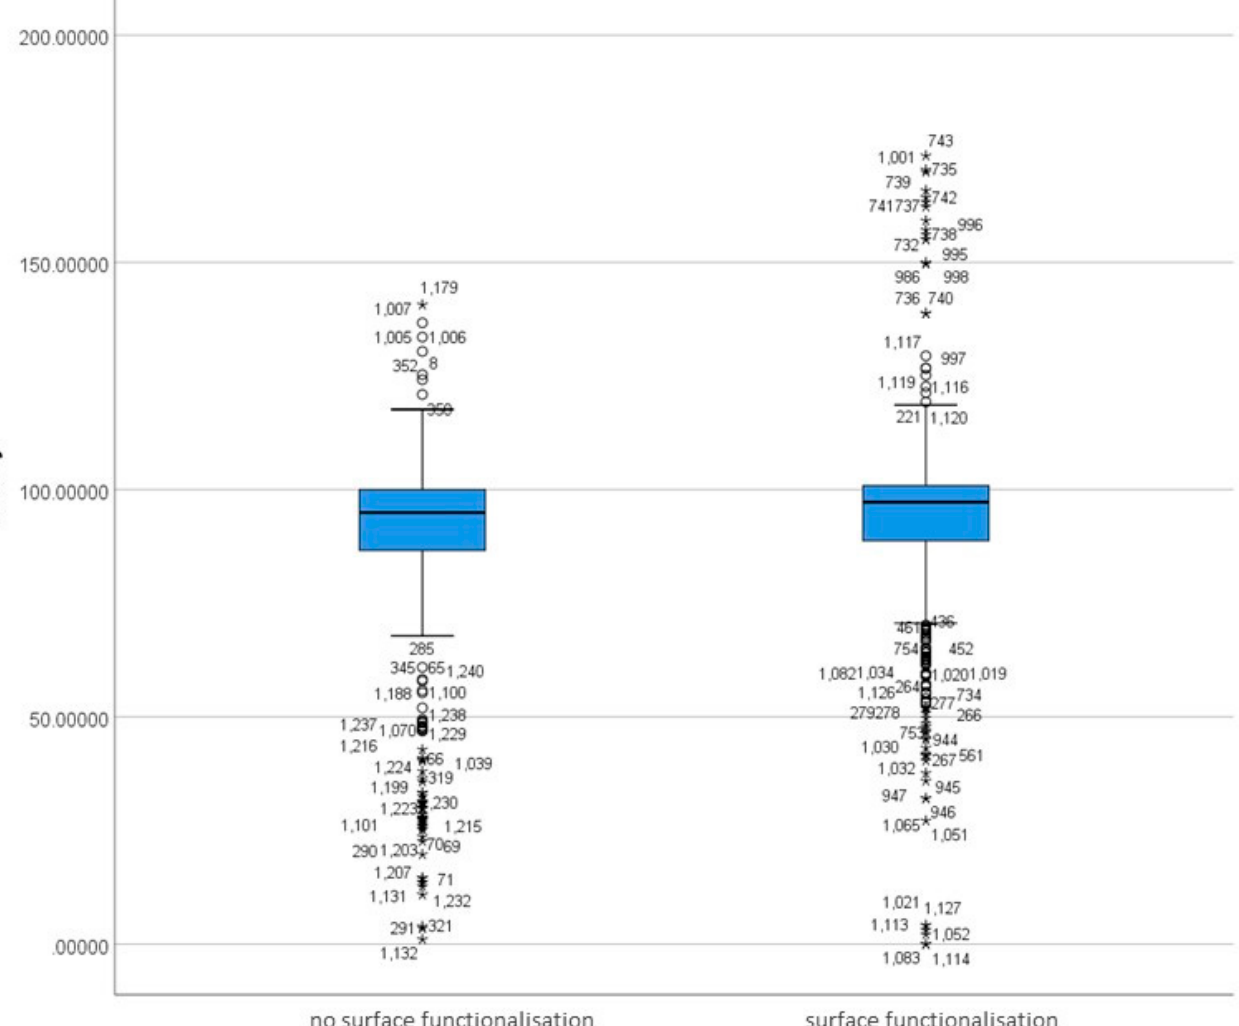
Figure 7. Distribution of functionalised and non-functionalised MSNs viability scores. The boxplot represents the distribution of viability scores in functionalised and non-functionalised MSNs. Any data points that are more than 1.5 box-lengths from the edge of their (blue) box are classified by SPSS Statistics as outliers and are illustrated as circular dots. Any data points that are more than 3 box-lengths away from the edge of their box are classified as extreme points (i.e., extreme outliers) and are illustrated with an asterisk (*).